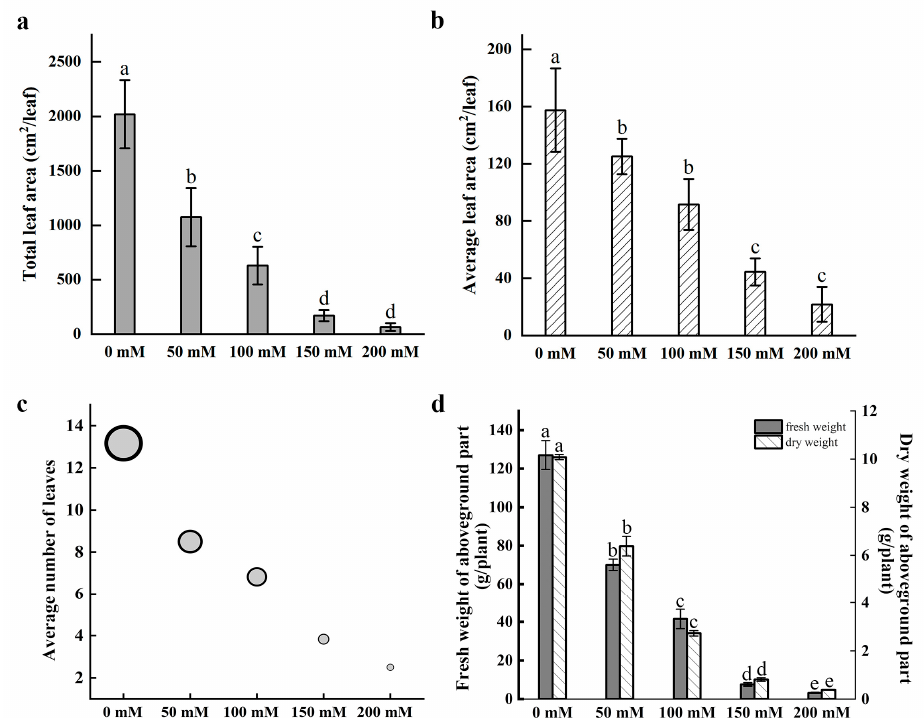
Figure 2. Growth metrics of water lily plants after salt stress treatment. ( a ) Total leaf area per plant. ( b ) Average leaf area per leaf. ( c ) Average number of leaves per plant. ( d ) The fresh weight (FW) and dry weight (DW) of the aboveground parts of plants. Data are the means of three biological replicates (±SDs). Different letters indicate statistically significant differences ( p < 0.05).